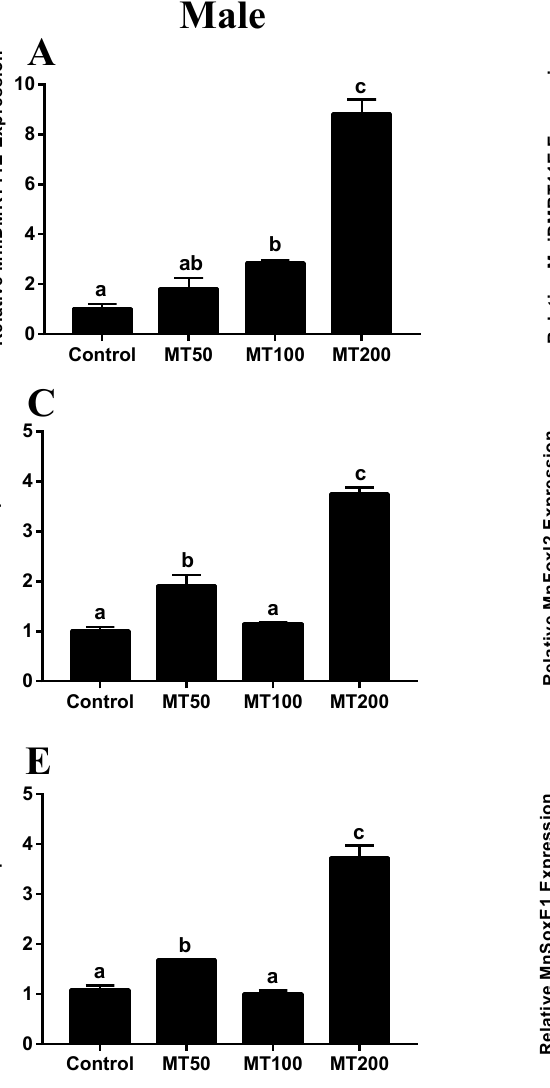
Figure 6. Expression characterization of MniDMRT11E , MnFoxl2 , and MnSoxE1 in male and female prawns treated with different concentrations of MT for 40 days. ( A , C , E ) Expression levels of MniDMRT11E , MnSoxE1 , and MnFoxl2 in male prawns treated with different concentrations of MT for 40 days; ( B , D , F ) expression levels of MniDMRT11E , MnSoxE1 , and MnFoxl2 in female prawns treated with di ff erent concentrations of MT for 40 days. The amount of MniDMRT11E , MnFoxl2 , and MnSoxE1 mRNA was normalized to the EIF transcript level. Data are shown as mean ± SEM of whole prawns from separate individuals in the same group (n = 3). Lowercase letters indicate the di ff erence in expression between di ff erent samples.